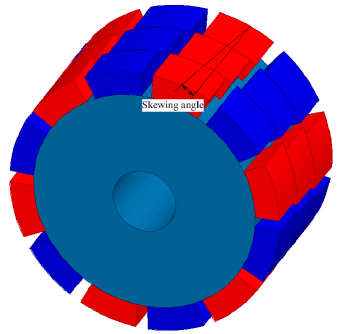
Figure 9. Magnet skewing design of the CPM.